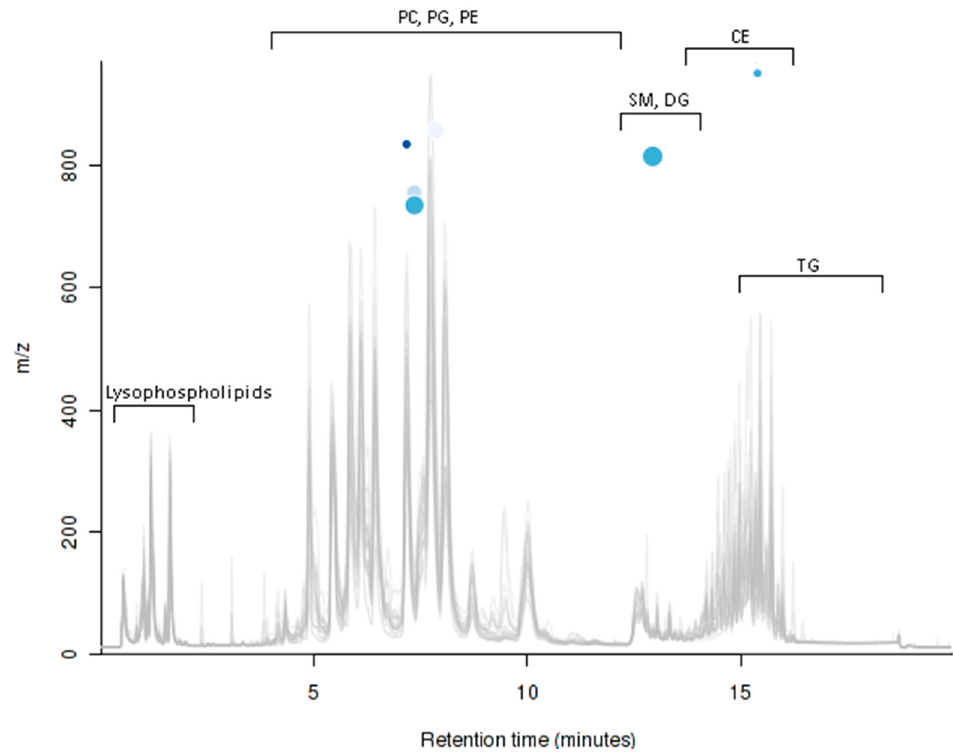
Figure 7. Cloudplot of the multigroup comparisons of the total ion chromatograms of winter fasted, winter fed and autumn fed with metabolic data visualization in the positive ionization mode. The six blue spheres represent the variably expressed features between the groups. The color of the sphere indicates the p -value of the feature (the lower the p -value the darker the color) and the larger diameter indicates the fold change, including the abundance and intensity of the feature (the larger the diameter, the larger intensity of the feature). Hyphenations in the figure: PC, phosphatidylcholines; PG, phosphatidylglycerols; PE, phosphatidylethaloamines; SM, sphingomyelins DG, diacylglycerols; CE, cholesterol esters and TG, triacylglycerols are denoting the common retention times in the system for the different metabolites, which were added in the figure for visualization.